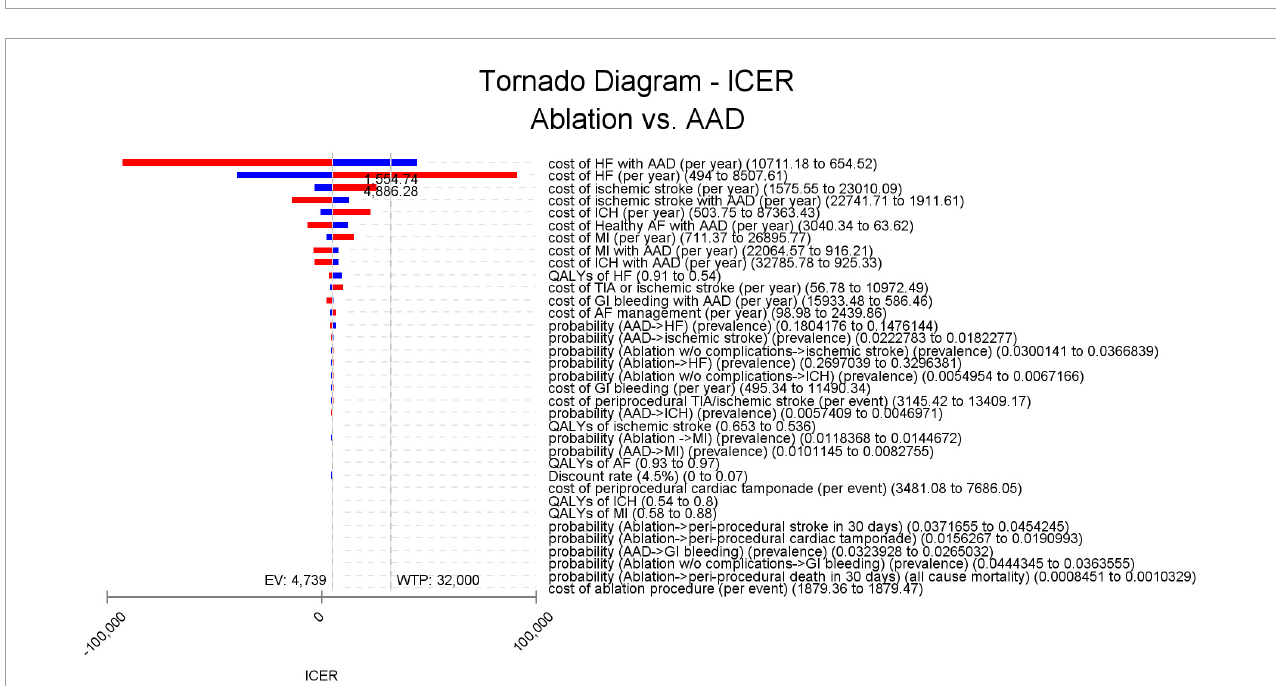
FIGURE3 Tornado diagram for deterministic sensitivity analysis. The vertical line represents the ICER in the base-case analysis (US $4,738.5/QALY) and WTP thresholds (US $32,000/QALY), respectively, and the horizontal bars represent the variation of the ICER given the variations in parameters driving the model outcomes. The ranges of the variations are represented by the lower (blue bars) and higher (red bars) ICER values. AAD, antiarrhythmic drug; AF, atrial fibrillation; EV, expected value; GI, gastrointestinal; HF, heart failure; ICER, incremental cost-effectiveness ratio; ICH, intracranial hemorrhage; MI, myocardial infarction; QALY, quality-adjusted life-year; TIA, transient ischemic attack; WTP, willingness to pay.